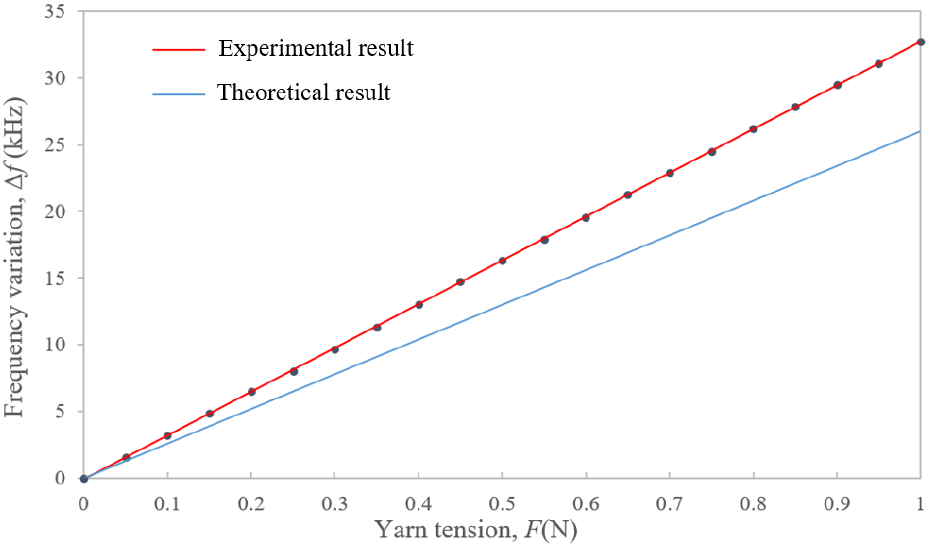
Figure 12. Sensitivity analysis results of the simply supported beam SAW yarn tension